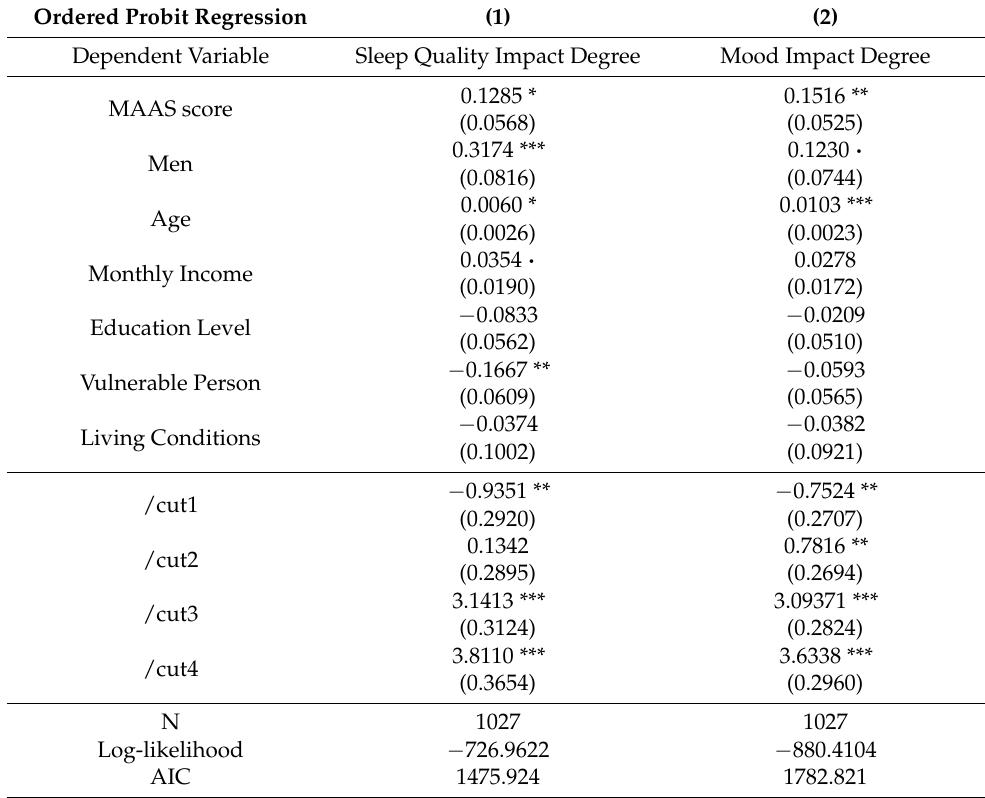
Table 5. Ordered probit regression models for